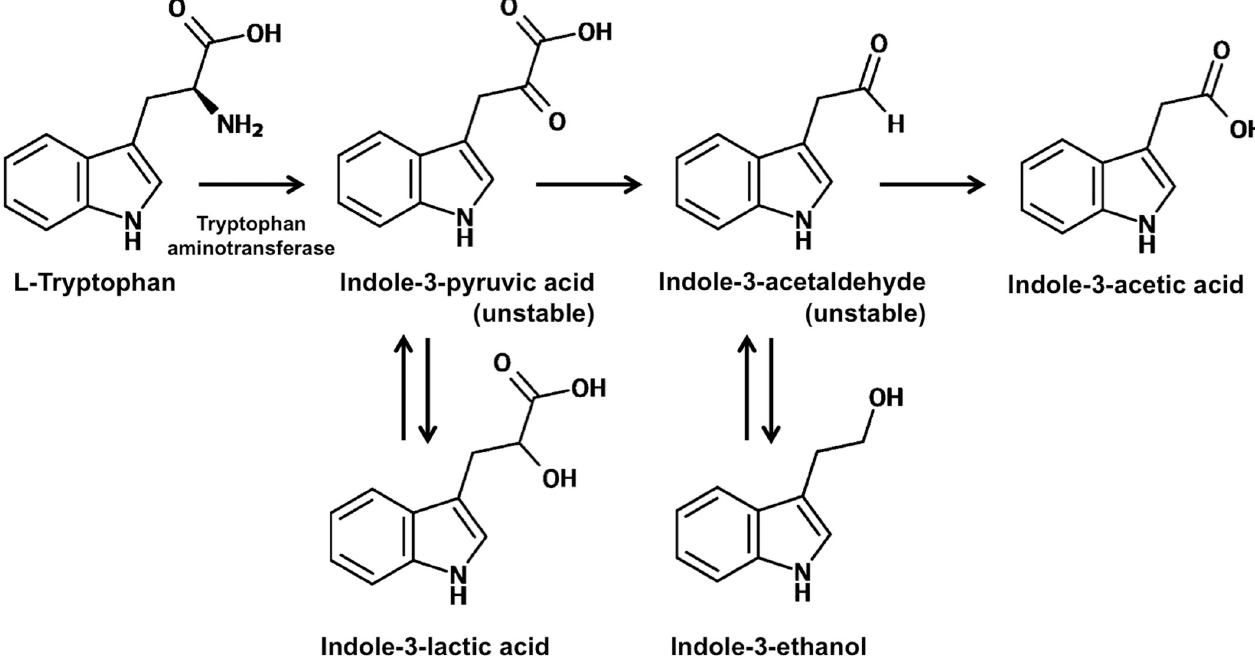
Fig 5. Proposed indole-3-acetic acid biosynthetic pathway of A . odoratus , G . suthepensis , Ph . Portentosus , Pi . orientalis Pi . albus and Sc . suthepense . The proposed pathway is based on experimental evidence observed in this study and the evidence of the intermediate compounds.